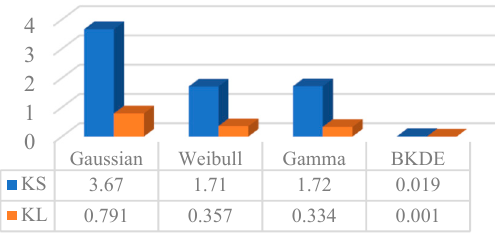
Figure 7. Comparison of clutter fitting result.